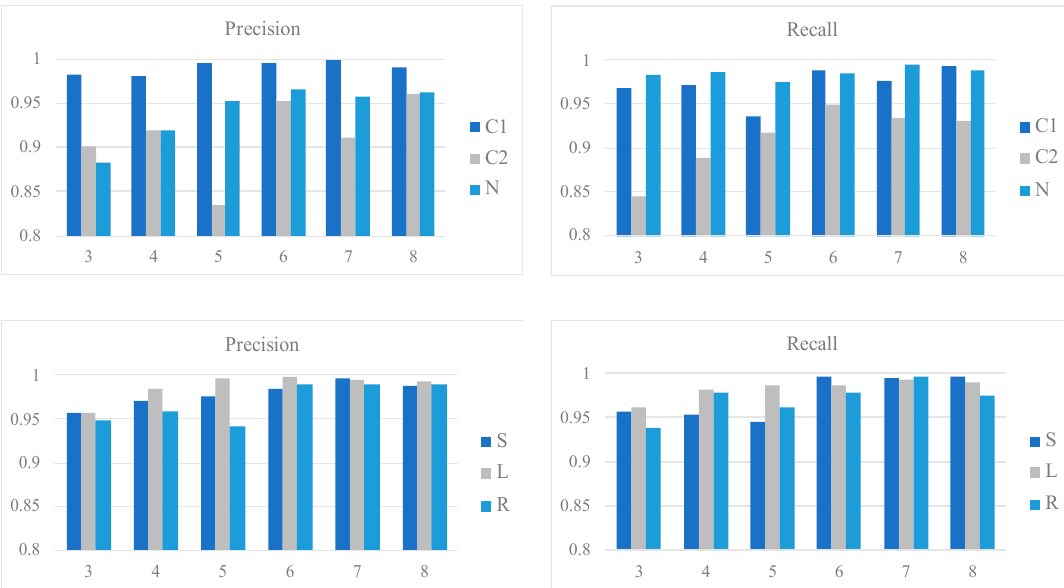
Figure 7. Class-wise performances of the qua_models and pos_models for the 4 s signal. The upper two bar plots show the precision and recall of the qua_models; whereas the lower two show those of the pos_models. The x-axis in each plot corresponds to the number of Conv